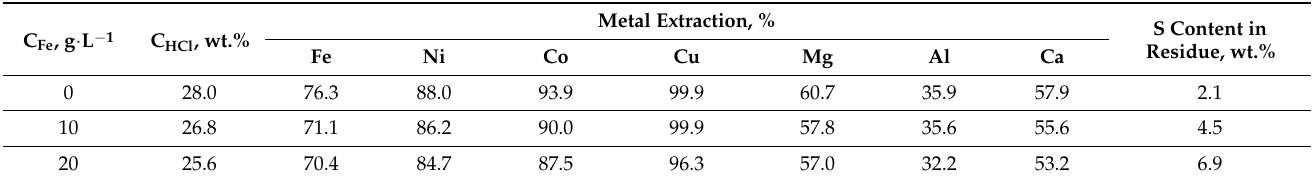
Table 2. The influence of iron concentration in the initial hydrochloric acid solution on the leaching of slag sample 774. Conditions: t = 80 ± 2 ◦ C, S:L = 1:10, τ = 5 h.